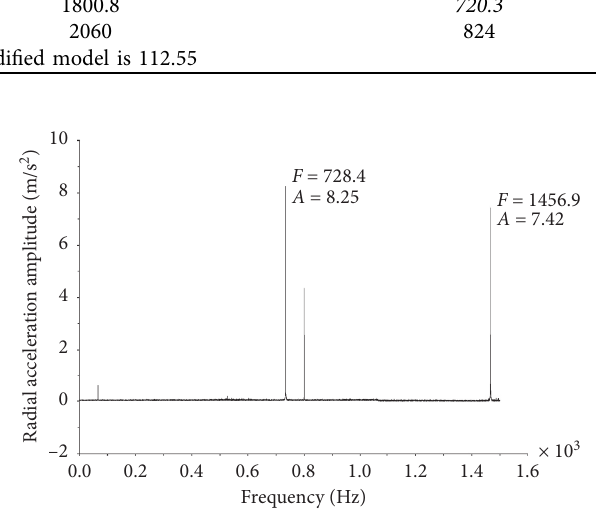
Figure 9: Radial acceleration of the modified model. Table 9: Simulation result comparisons.